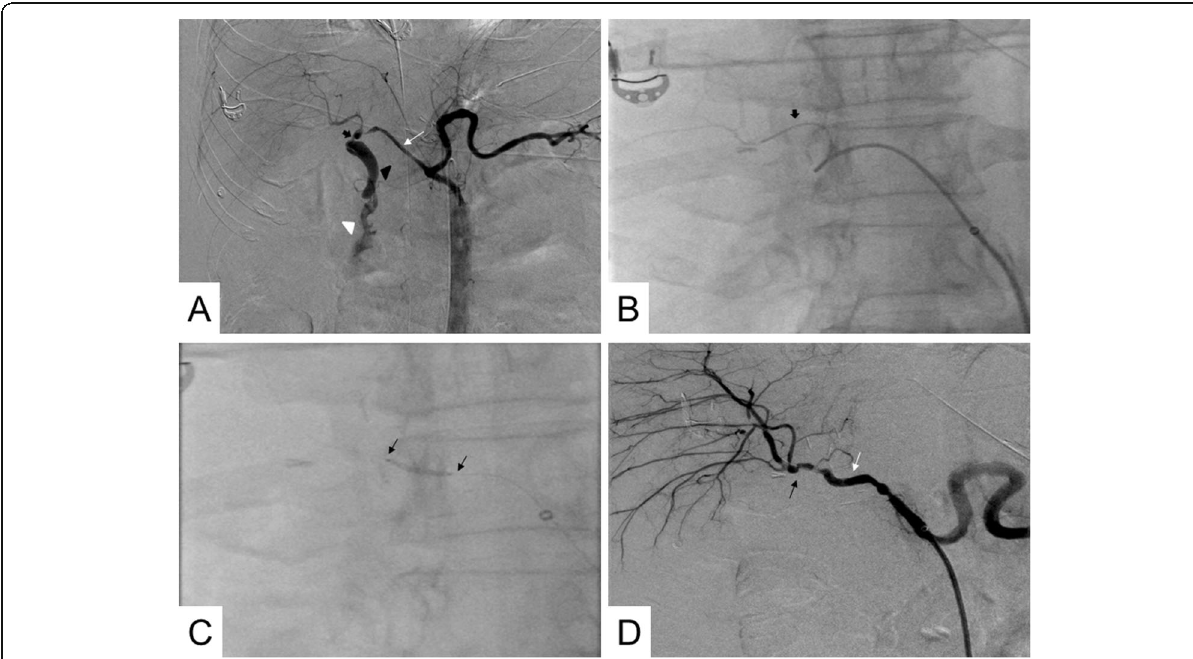
Fig. 2 Endovascular treatment of the HAP and the ABF. a DSA of the celiac trunk demonstrating a HAP (thick black arrow) coming off the main hepatic artery just before its bifurcation (thin white arrow). The bile duct is filled with iodinated contrast, confirming the presence of an ABF with hemobilia (blackhead arrow). Contrast flush within the duodenum demonstrated the presence of an upper GI hemorrhage (white head arrow). b- c Fluoroscopic images during the positioning of the microcatheter after crossing the target lesion (thick black arrow) ( b ) and the introduction and release of a covered stent with an expandable balloon (between thin black arrows) ( c ). d DSA demonstrating complete exclusion of the HAP, resolution of the ABF, the permeability of the main hepatic artery (thin white arrow), and its intrahepatic branches. We noted focal stenosis in the hepatic artery and its branches, related to vasospasm and vessel remodeling after manipulation (thin black